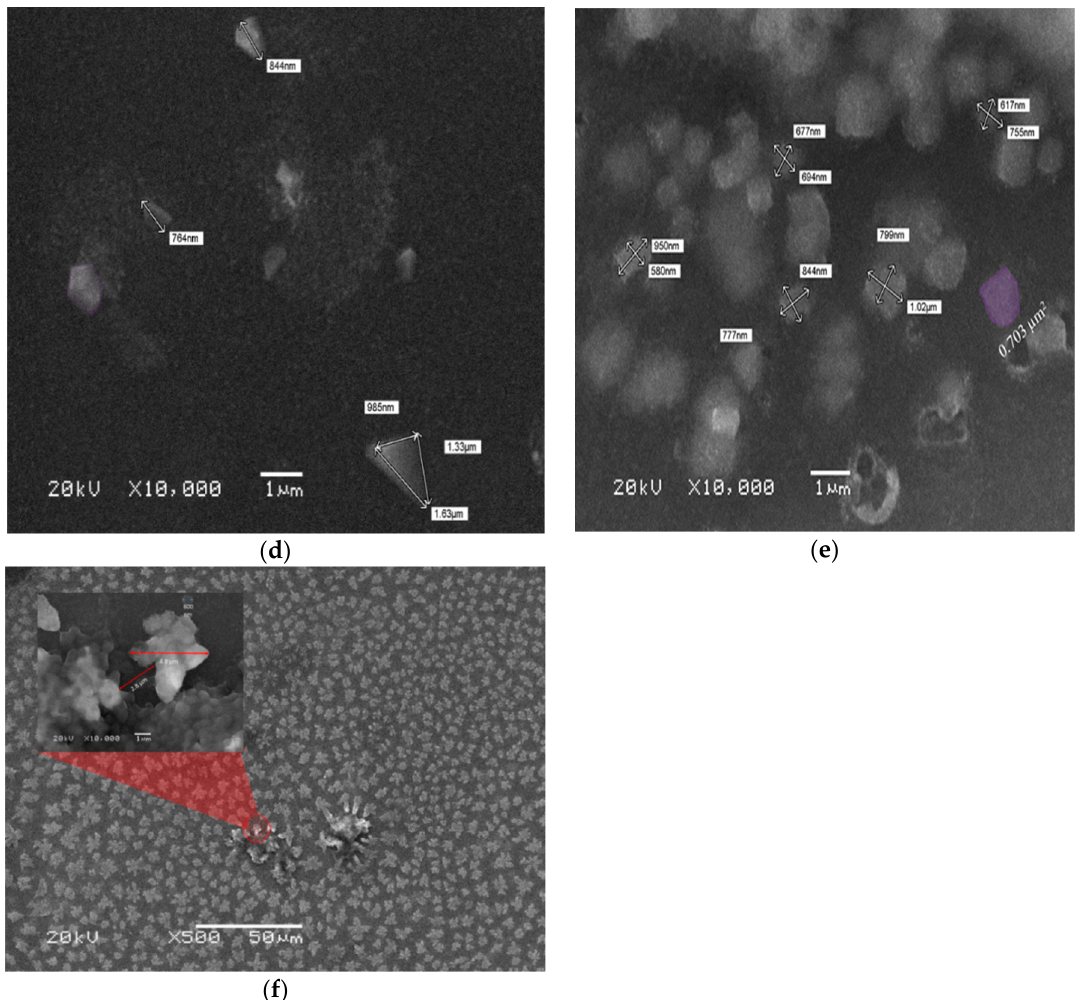
Figure 5. ( a – c ) SEM images of the oligomer at thicknesses of 70, 88, and 270 nm and speed 3000 rpm. ( d – f ) SEM images of the oligomer at thicknesses of 95,127, and 380 nm and speed 2000 rpm.